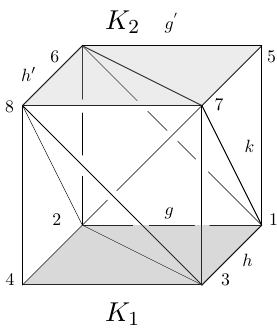
Figure 9. A simple triangulation of a 3-cylinder. Vertex ordering is obvious, and arrows are thus omitted. The surface 5678 and 1234 are the two boundaries. We let [12] = [34] = g, [24] = [13] = h, [56] = [78] = g ′ , [57] = [68] = h ′ , [15] = [26] = [37] = [48] = k